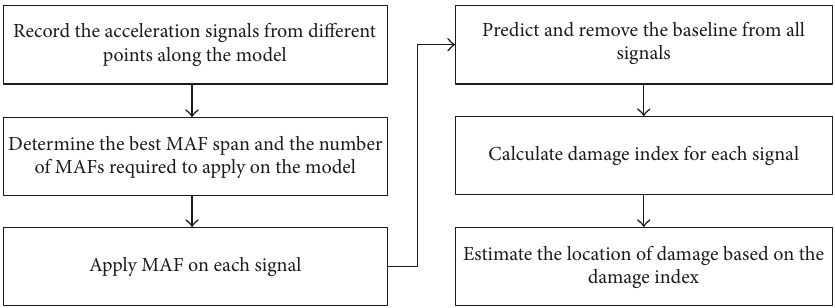
Figure 3: General flowchart of damage detection based on MAF.